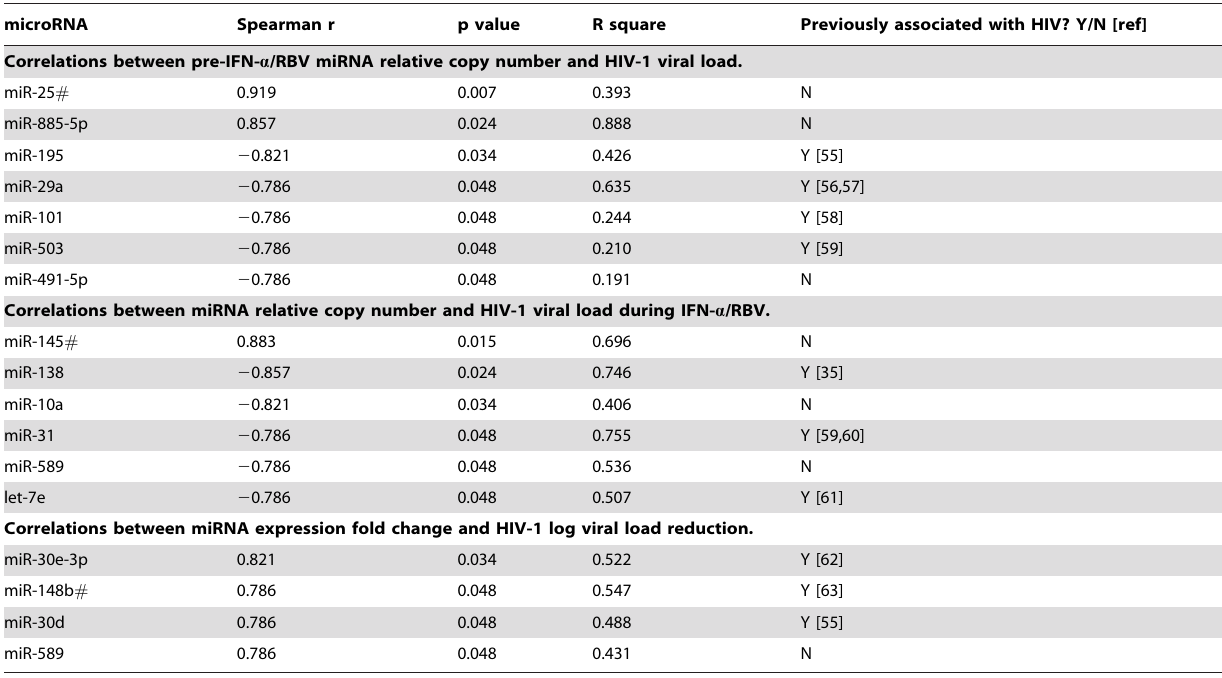
microRNA Spearman r